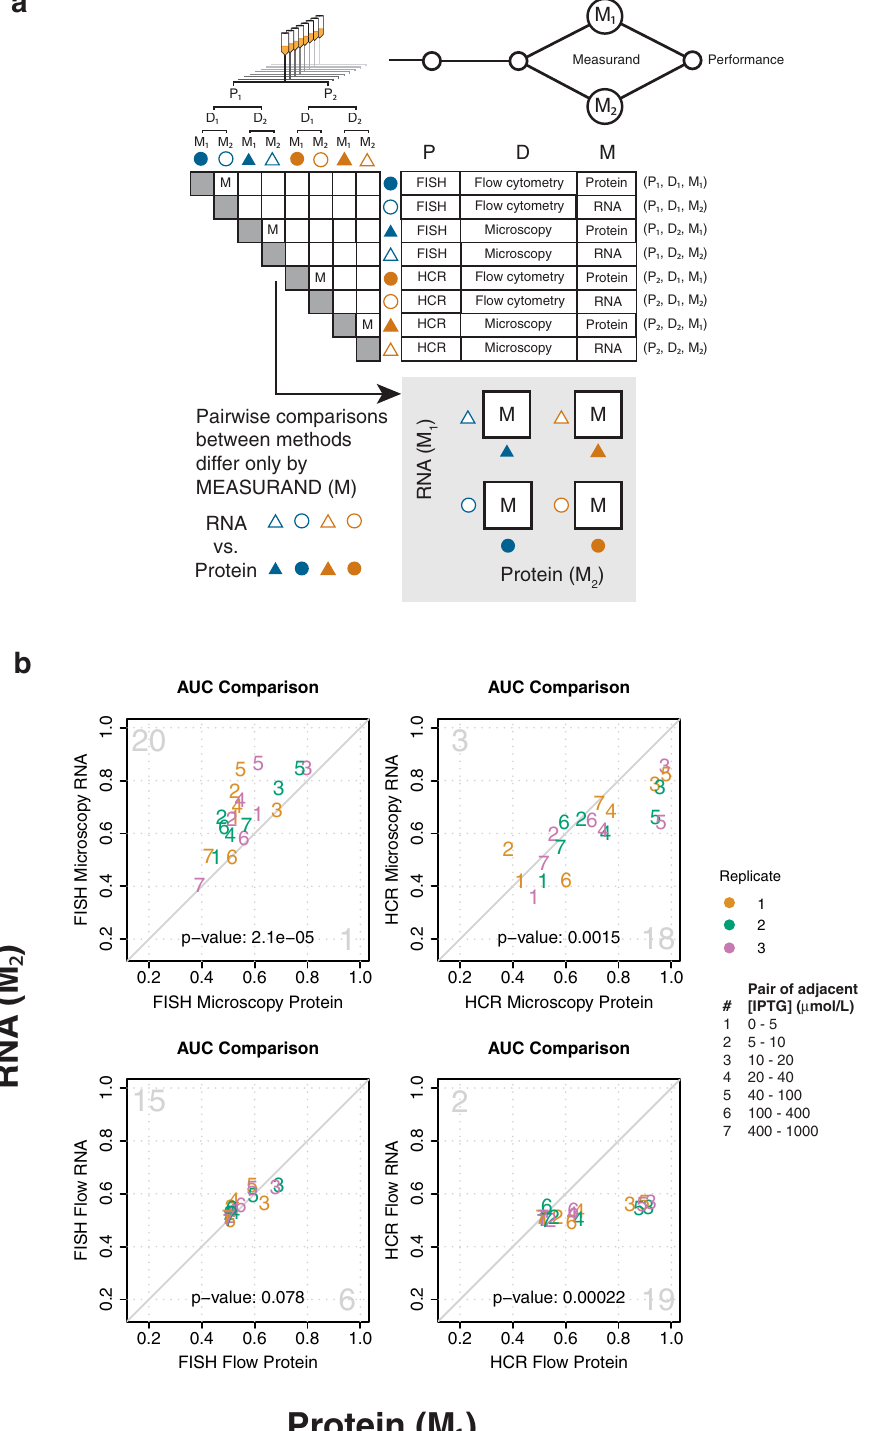
Fig. 3 Method performance can be attributed to measurand. a Pairwise comparisons of methods that share the same steps for sample preparation and signal detection, but differ in measurand ( “ M ” squares in matrix), are used to attribute measurement performance to measurand. The four boxes containing “ M ” under the matrix represent these same pairwise comparisons. b Pairwise AUC plots of measurements in ( a ) are used to compare resolvability between RNA and protein measurands. Diagonal line indicates equivalent resolvability between the two methods. Pairs of adjacent IPTG concentrations are shown as numbers within the plots, as indicated in the fi gure legend. Color indicates biological replicates one (orange), two (green), and three (purple), as indicated in the fi gure legend. Large gray numbers in the top-left and bottom right-corners indicate how many AUC ’ s were higher for the method plotted on the y -axis or x -axis, respectively. The two-sided p -values for a sign test are shown within each